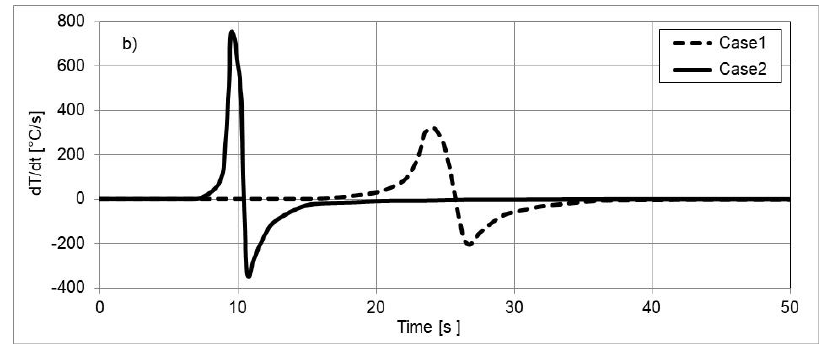
Figure 5. For Case 1 and Case 2 at the cross-section location Y = 60.0 mm and Z = − 1.1 mm presented evolution for PM N of: ( a ) temperature; ( b ) temperature change rate.